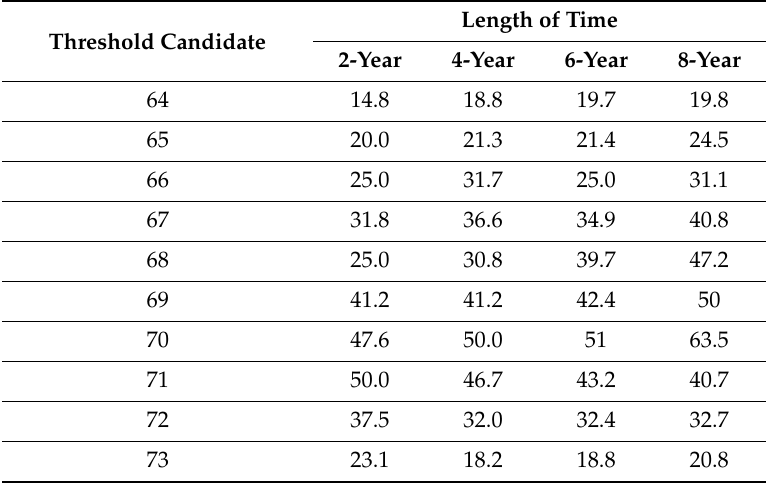
Table 5. Comparison of CSI scores resulting from di ff erent-length samples for the month of June at the HKSC-KP